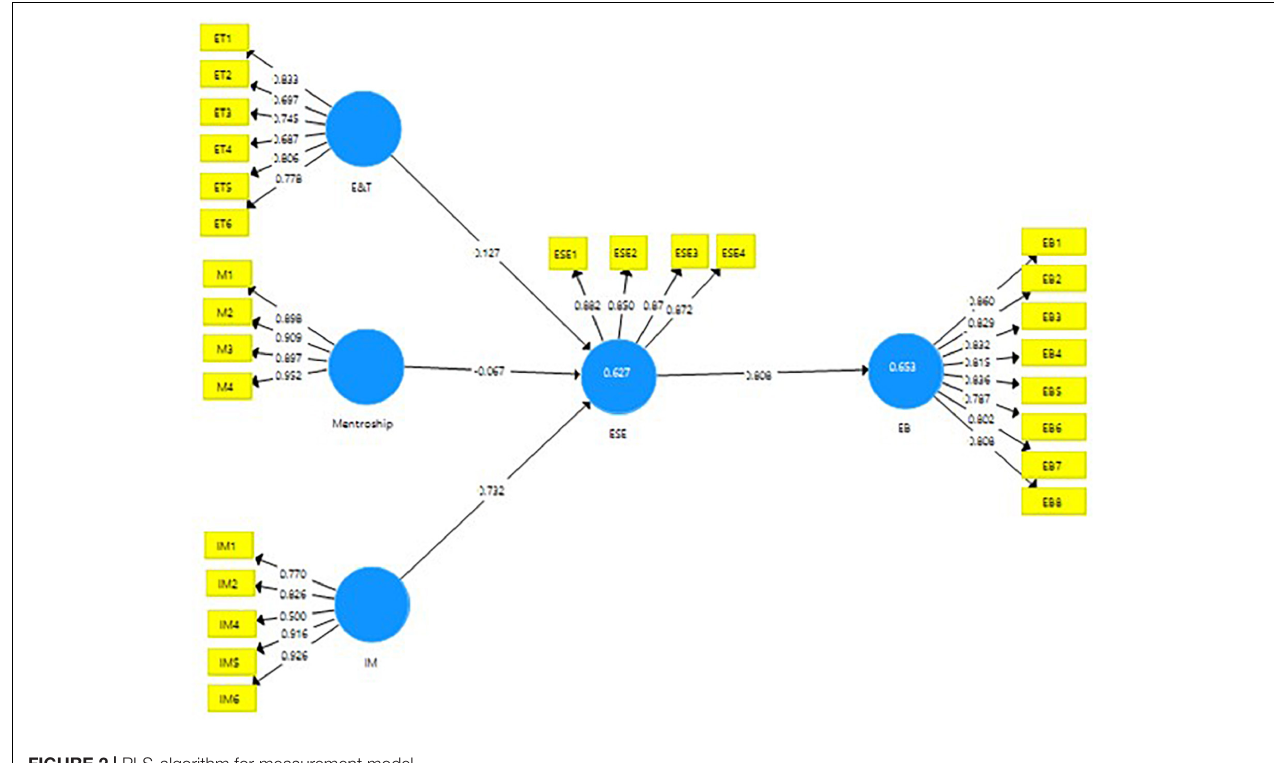
FIGURE 2 | PLS-algorithm for measurement model.